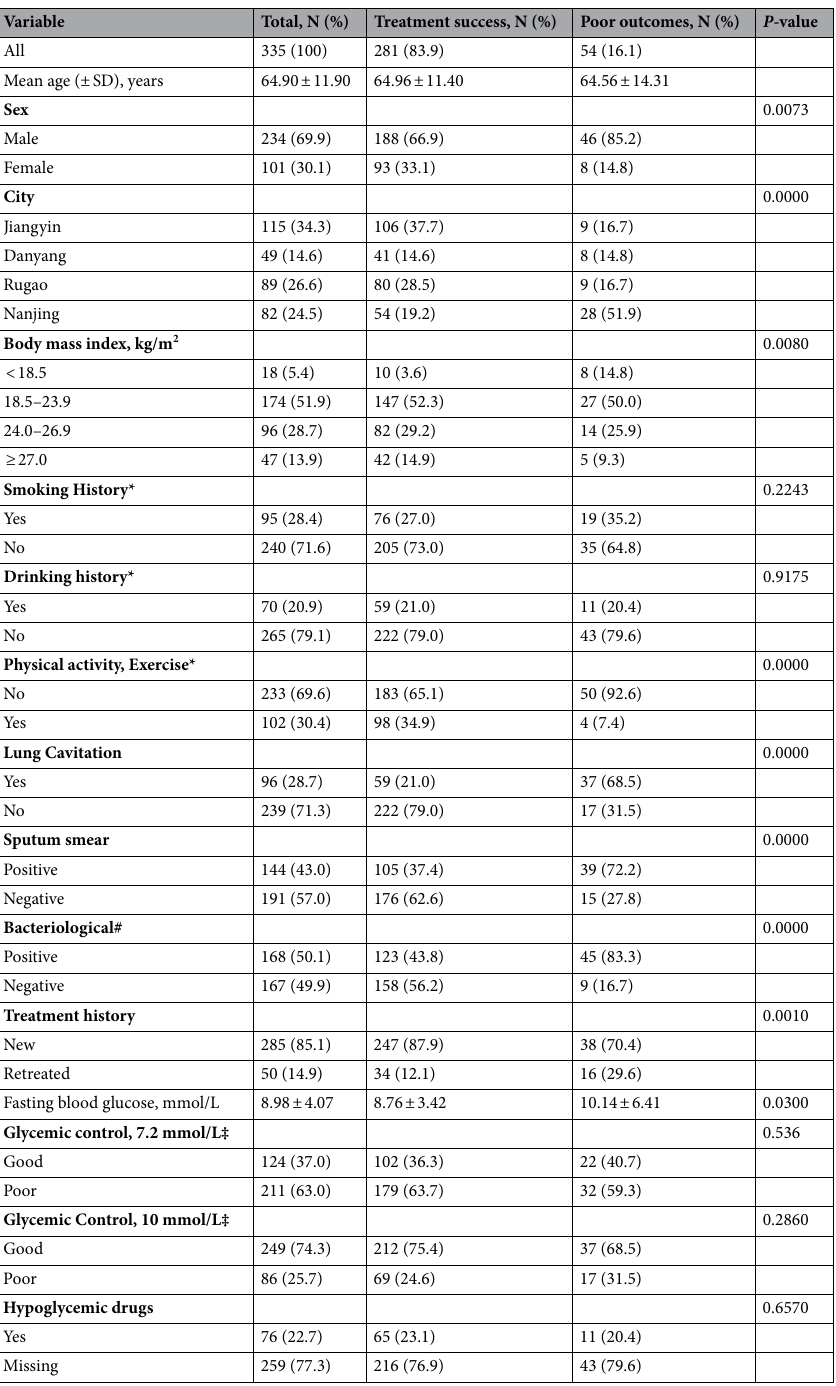
Table 1. Characteristics of 337 Persons Living with Diabetes Diagnosed with Tuberculosis in Eastern China. *Physical Activity, Smoking History and Drinking History were self-reported, including currently or